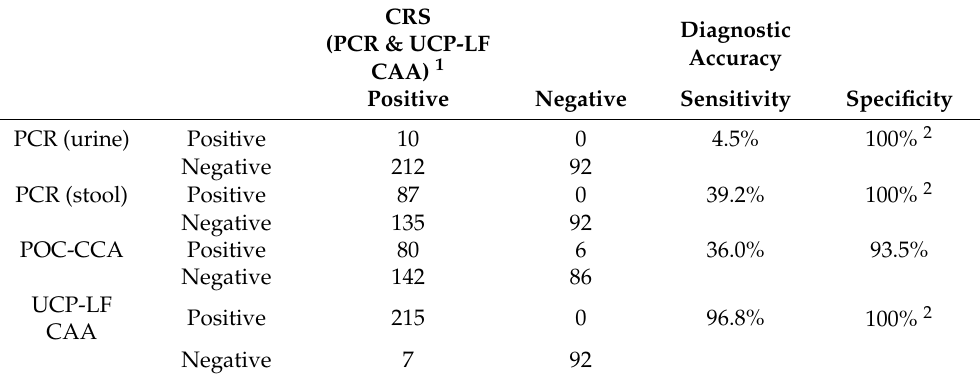
Table 3. Sensitivity and specificity of polymerase chain reaction (PCR) in urine and stool, point- of-care circulating cathodic antigen (POC-CCA), and the up-converting particle circulating anodic antigen (UCP-LF CAA) urine test compared to a composite reference standard (CRS). CRS